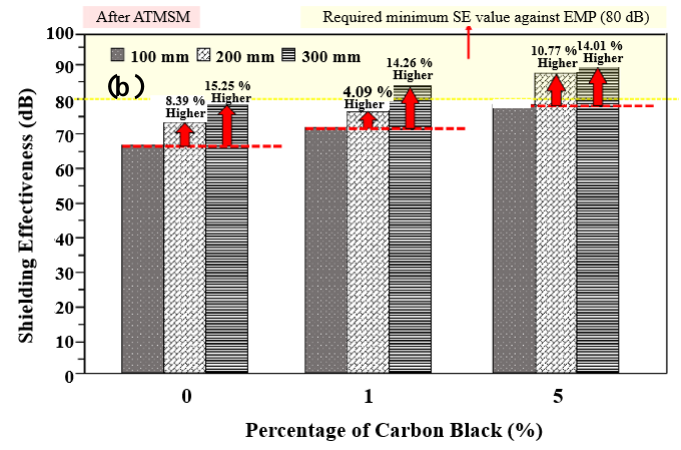
Figure 8. EMP performance of specimens after application of the Al – Zn coating ( a ) at a particular thickness with 0, 1, and 5 wt% carbon black and ( b ) with a fixed amount of carbon black at different thickness of concrete.